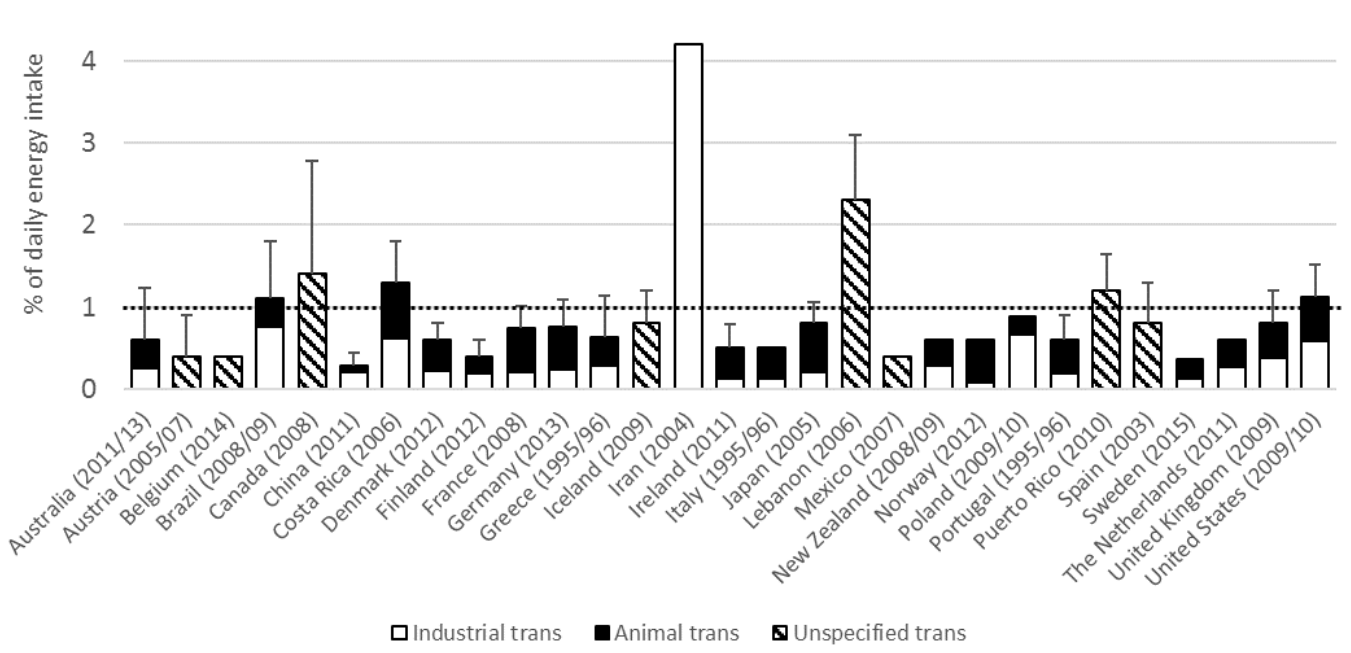
Figure 1. Mean (Standard Deviation) intakes of trans fat and its sources in populations from 29 countries. Data represent estimates of population total trans fat intake reported by year of food composition data. The dotted line represents the maximal recommended intake level of trans fat [6].